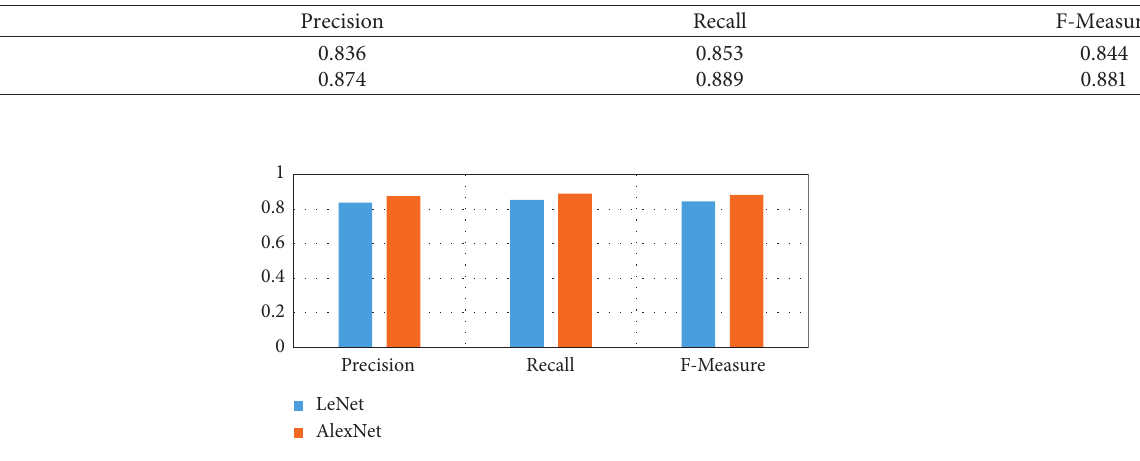
Figure 2: Performance comparison of both LeNet-5- and AlexNet-based models in Precision, Recall, and F-Measure.